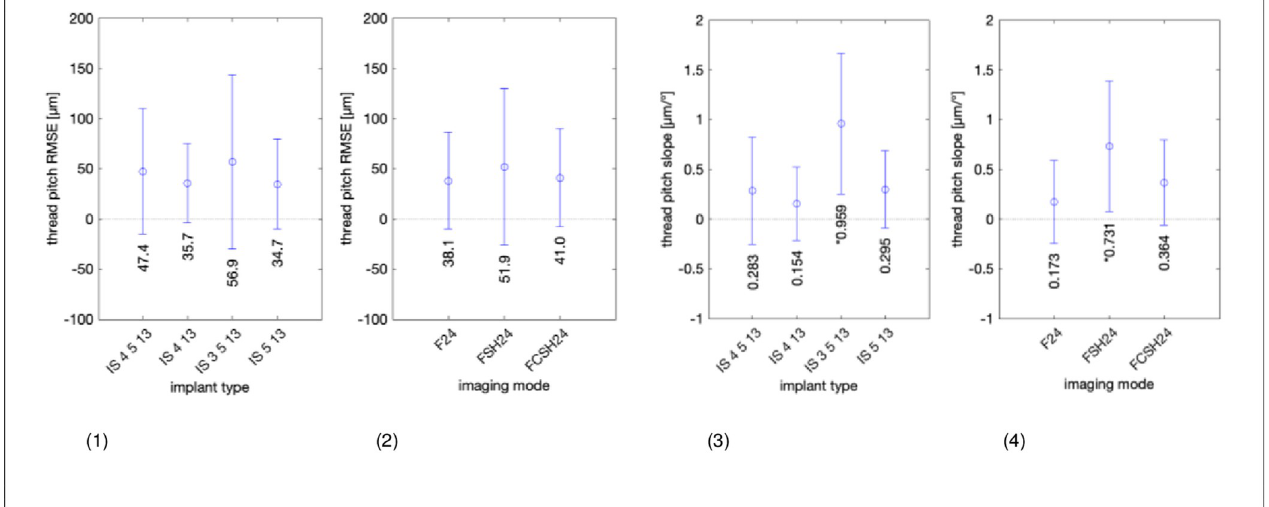
Fig 10. Root mean squared error (RMSE) and image angle dependence of measuring implant thread pitch with ultrasound. Left to right: (1) RMSE in micrometer with 95% CI error bars for each of the 4 implant samples. (2) Mean error in micrometer and 95% CI error bars for the 3 imaging modes (F24, FSH24, and FCSH24). (3 and 4) Same data as (1 and 2) but as dependence of image angle, i.e., the slope in each subplot combination of implant and imaging mode. The complete data are shown in S4